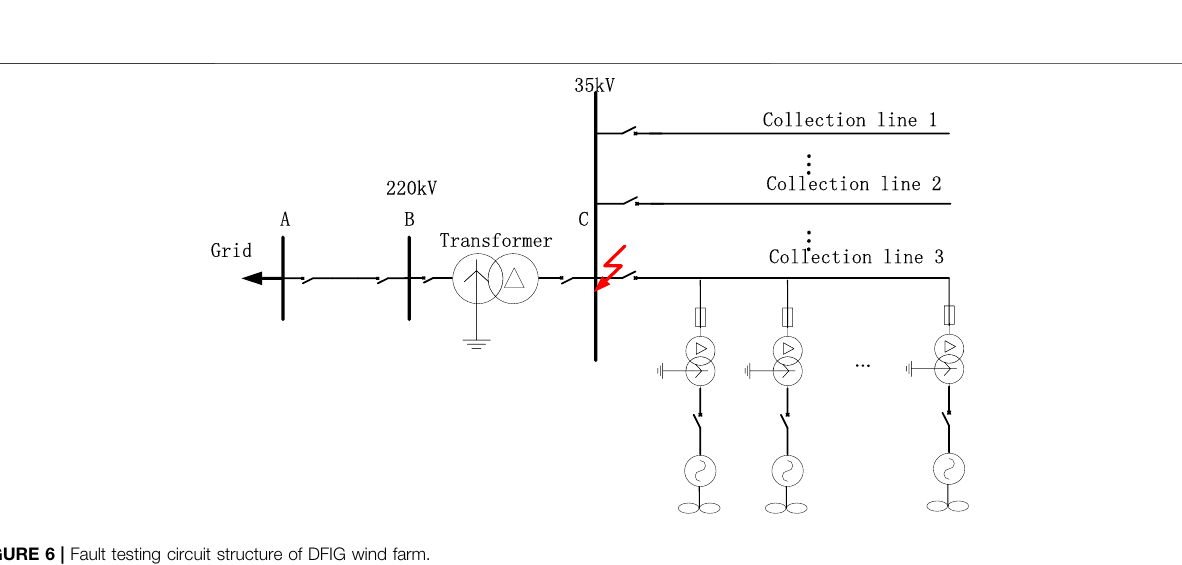
Frontiers in Energy Research |